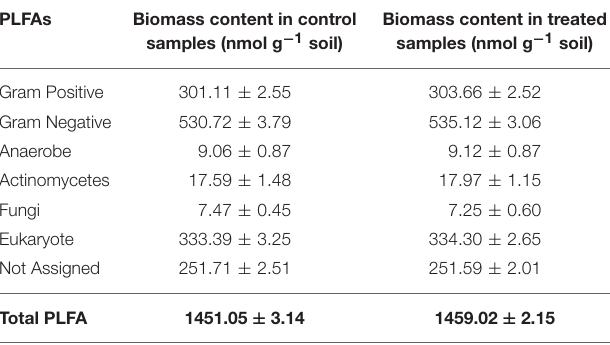
TABLE 5 | Soil microbial biomass analysis in treated pots by